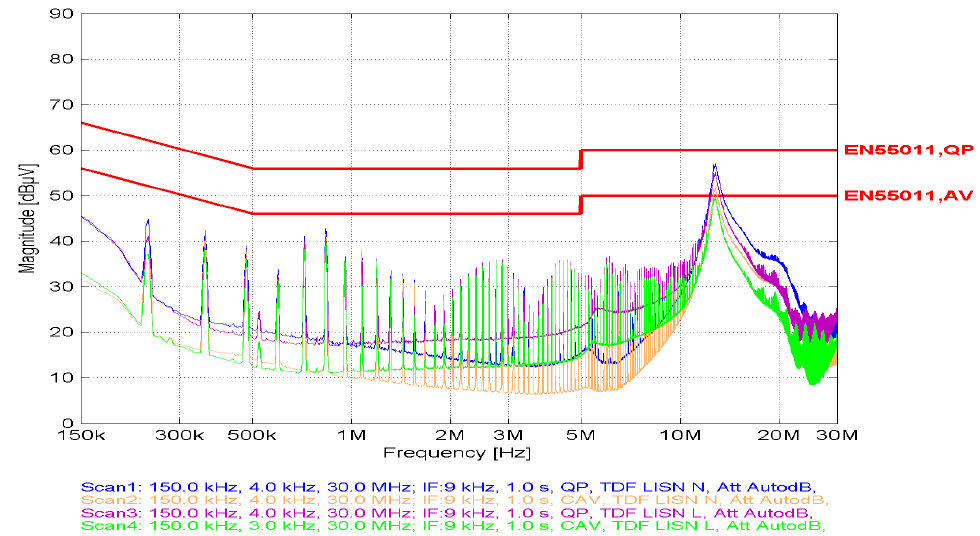
Figure 7. Attenuation level for ferrite No. 1 with the number of coils at 18 pcs. When analyzing this case in terms of maximum values below the limit, no significant changes were observed. At the same time, in the frequency range above 10 MHz, atten- uation values were obtained that are below the limit. However, further studies on the subsequent reduction in the number of turns showed that this case should be excluded from the analysis due to the probable measurement error. The obtained results for 15 coils allowed to carry out the tests for a greater step of changing coils (by 5 pcs.) (Figure 8).